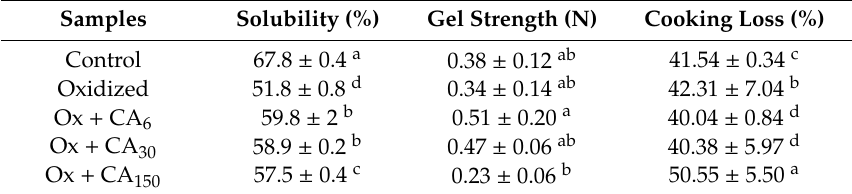
Table 2. Changes in solubility and gel properties of oxidized myofibrillar protein (MP) with chlorogenic acid (CA).